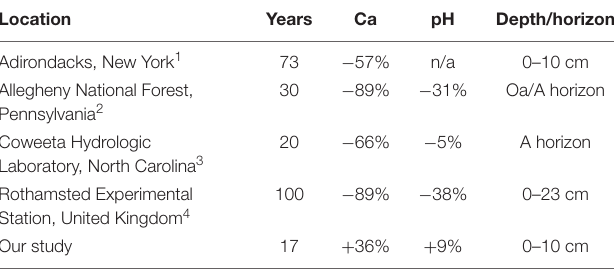
TABLE 2 | Comparison of retrospective studies investigating soil Ca and